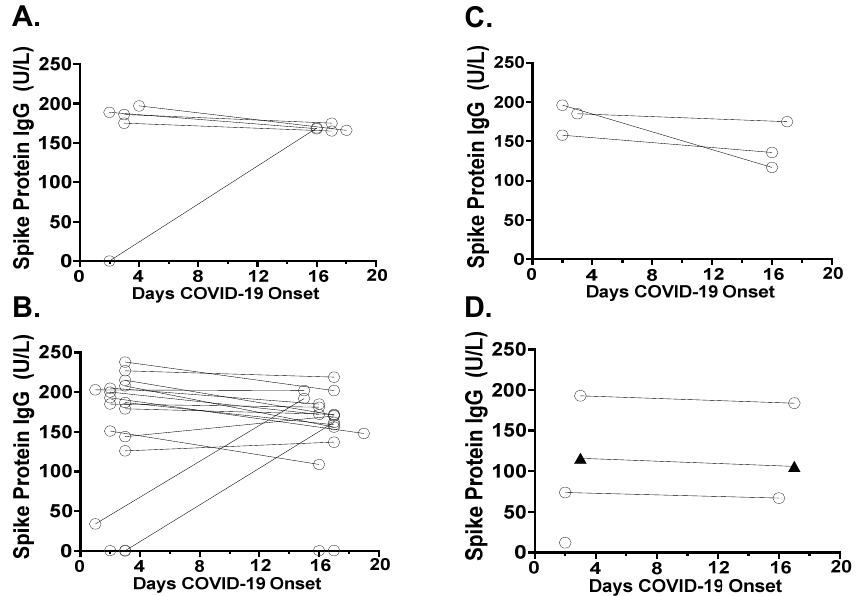
Figure 3. Anti-S-protein antibody levels of SARS-CoV-2 variants. The anti-S-protein antibody reactivity on day 2 or day 3 post COVID-19 onset of symptoms (POCS), and at follow up, day 16, or day 17 POCS: ( A ) alpha and beta variants, ( B ) delta variant, ( C ) delta plus variants, and ( D ) variants of the B.1.3.18 and B.1.525 PANGO lineages. Cut-off of Euroimmun Quant S-protein positivity >11 U/L.